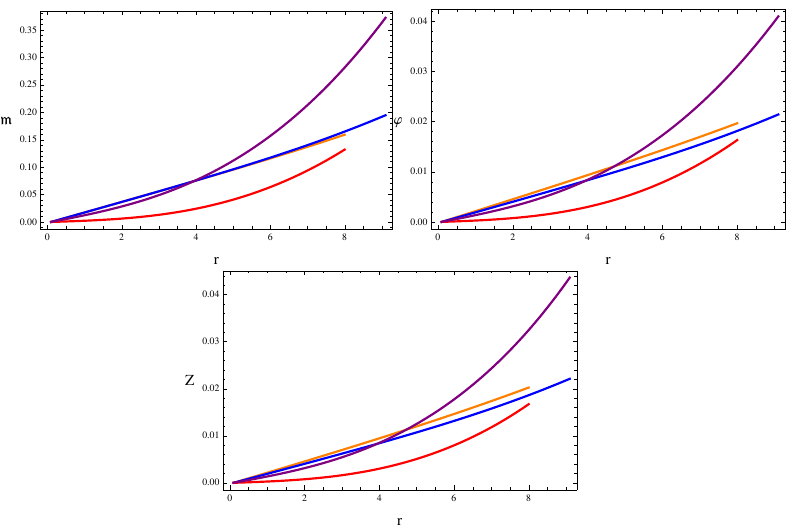
Figure 8. Behavior of mass, compactness and redshift versus r corresponding to ψ = 0.1 (Orange), ψ = 0.9 (Red) (Her X-1) and ψ = 0.1 (Blue) and ψ = 0.9 (Purple) (4U 1820-30) for solution